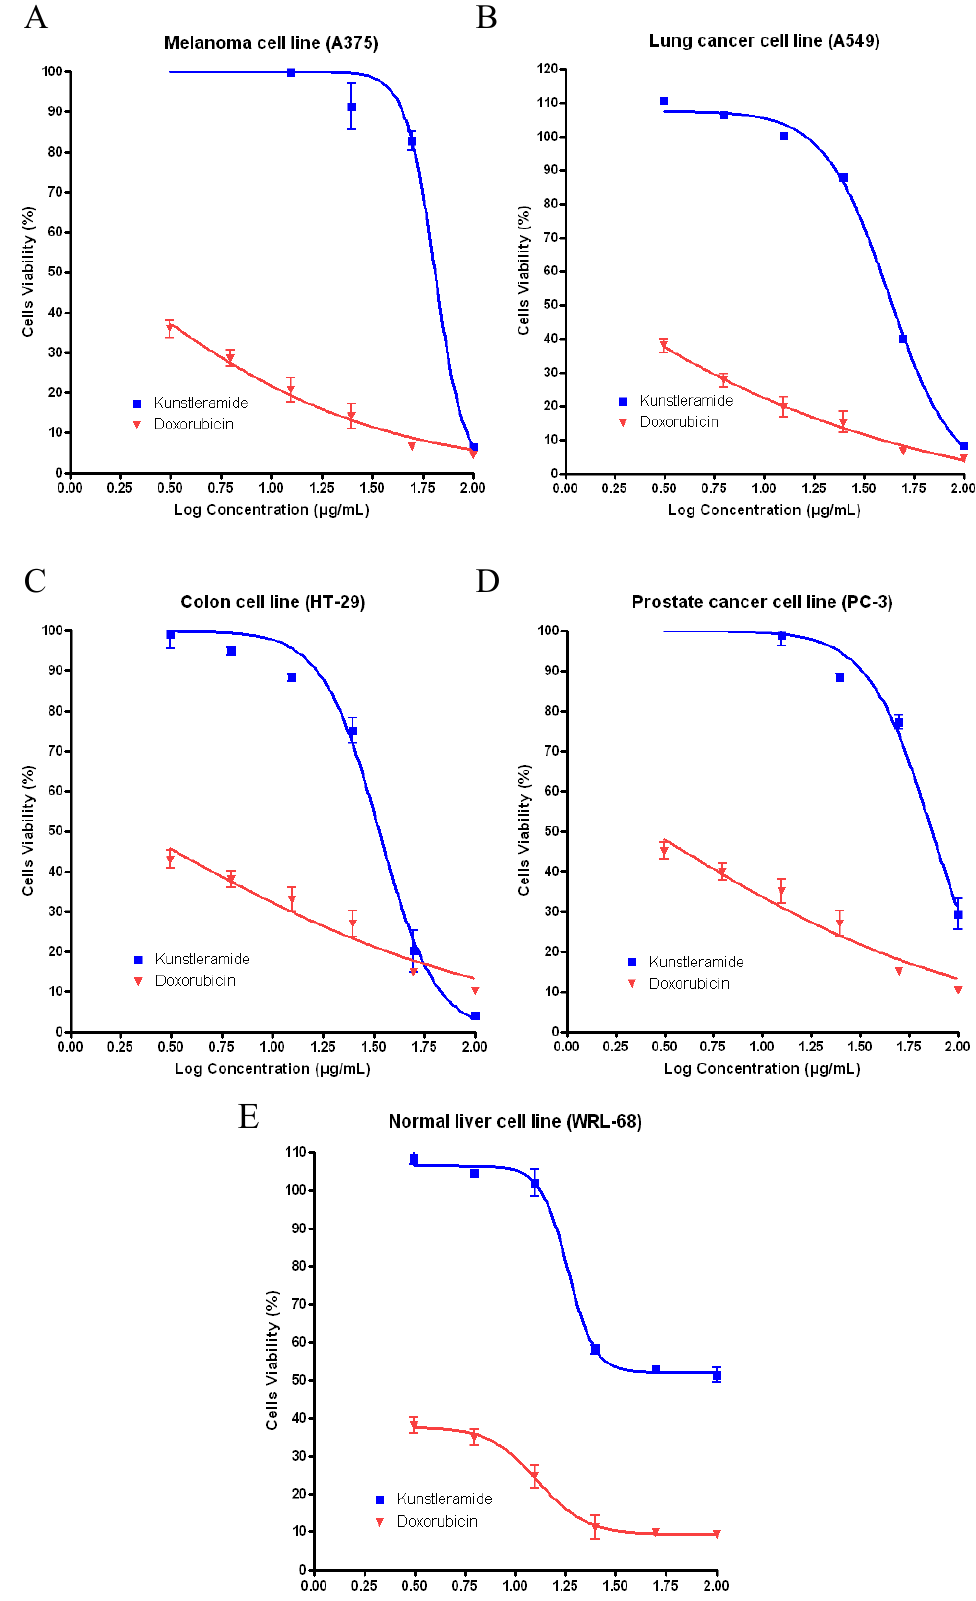
Figure 5. Dose-response curves (using GraphPad Prism) tested with ( − )-kunstleramide ( 1 ) and doxorubicin (positive control) in the MTT assays towards ( A ) A375, ( B ) A549, ( C ) HT-29, ( D ) PC-3 and ( E )